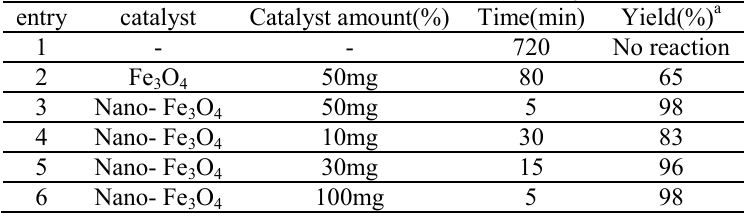
Table 1. The effect of amount of nano-Fe